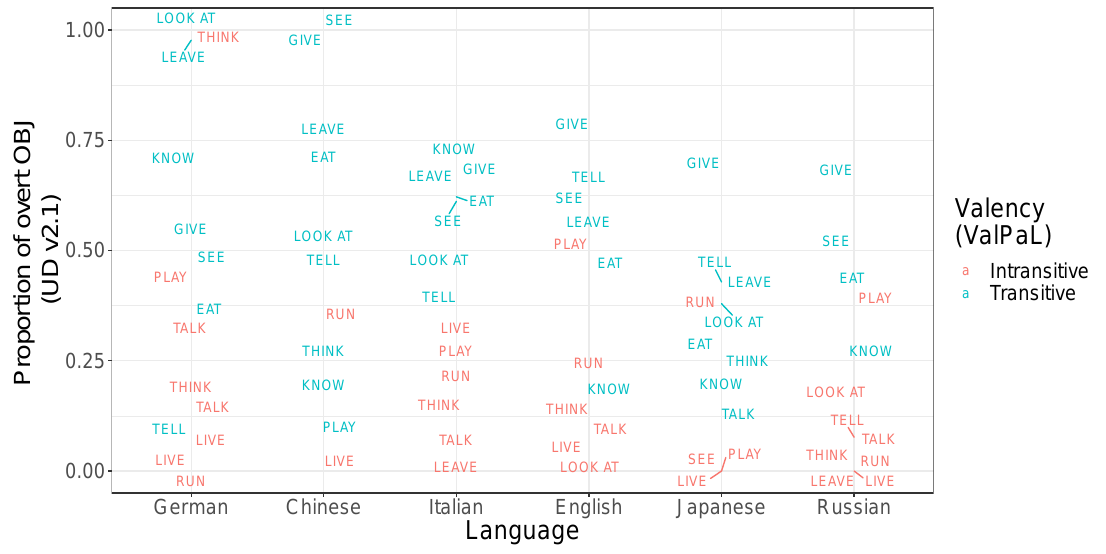
Figure 1: Distribution of verb meanings in six languages ( x axis) based on overt object-taking occurrences in corpus data (UD) as a measure of transitivity prominence ( y axis) set off against their classification in a valency database (color-coded). Lan- guages are sorted from most to least transitive, averaged across verb